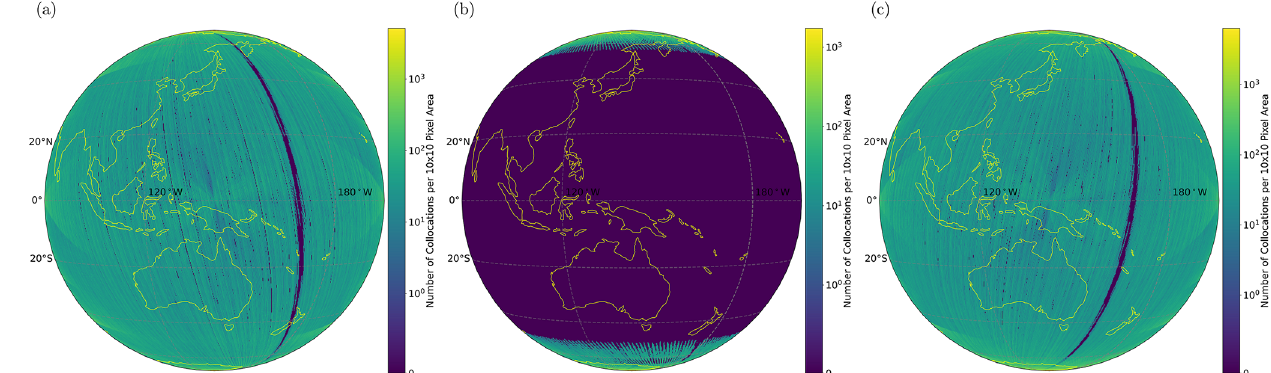
Figure 3. Heat maps of collocated AHI pixels within a 10-pixel by 10-pixel area in the AHI FOV for the full 2019 data set broken down by (a) day, (b) twilight and (c) night. The northern and southernmost region contain the highest concentration of collocated pixels as CALIOP is in a polar orbit, causing it to return to the same area in each AHI scene. Outside these regions, AHI pixels are relatively evenly distributed across the whole AHI FOV, with the exception of the region to the centre right of the FOV, which is due to AHI having gaps in coverage at 02:40 and 14:40UTC every